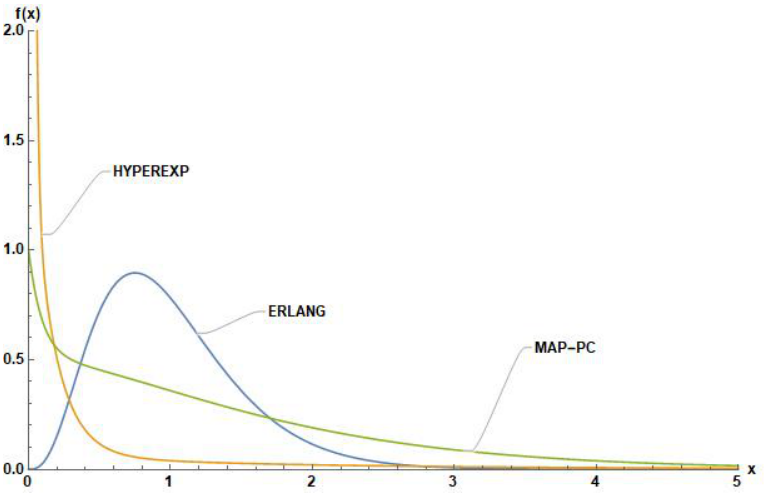
Figure 1. Probability density functions of the inter-arrival times.